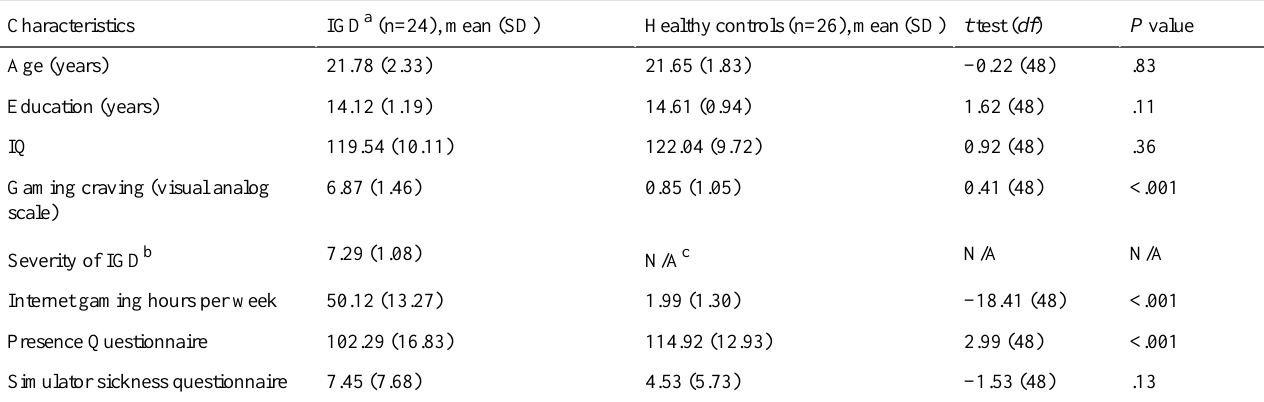
Table 1. Demographic and clinical characteristics of participants with internet gaming disorder versus healthy